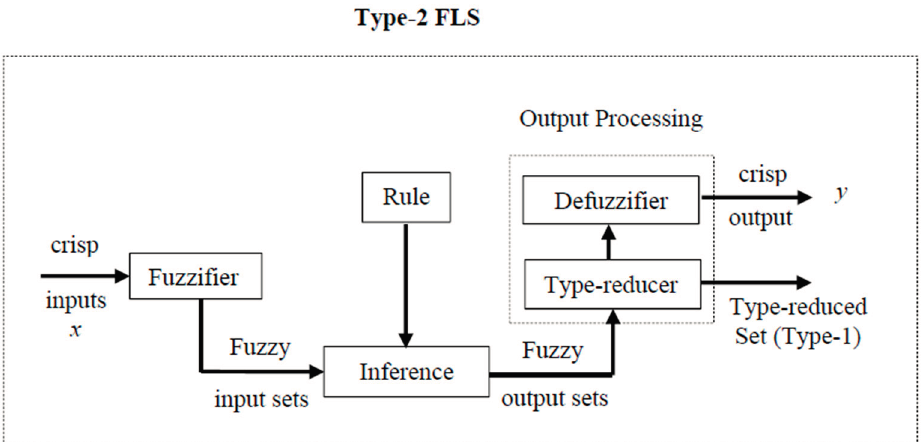
Figure 2. Basic structure of T2 fuzzy inference